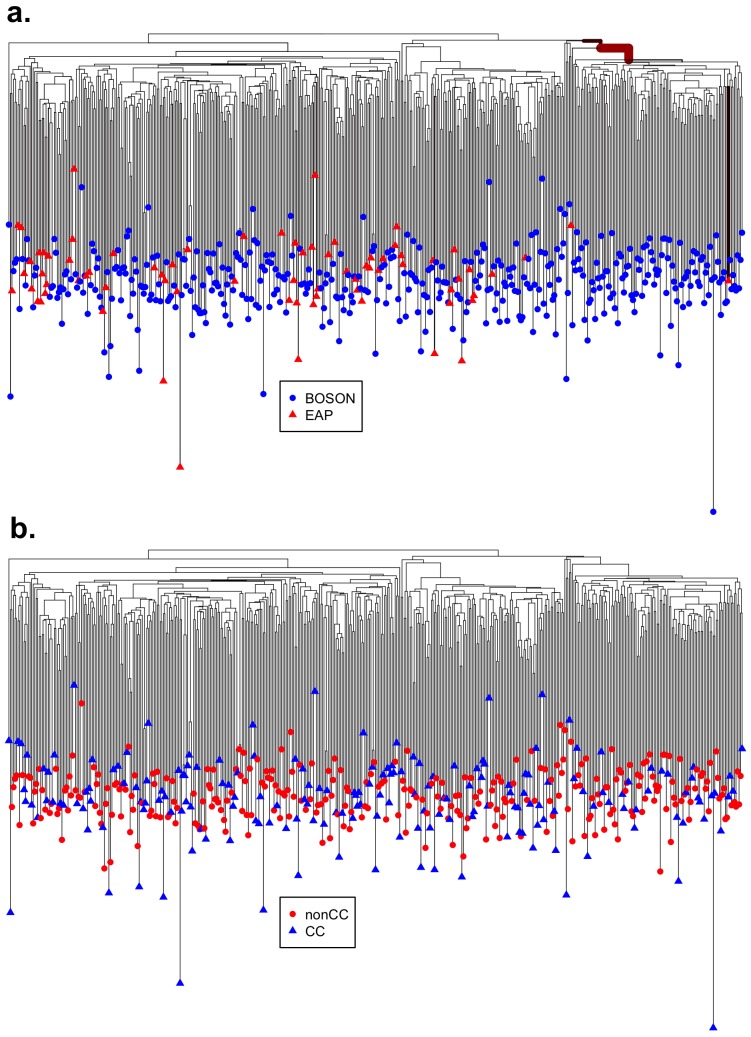
Distribution of (a) cohort from which the sequences were obtained (BOSON N = 411 or EAP N = 74) and (b) host IFNL4 SNP rs12979860 genotypes (CC or non-CC) on the virus phylogenetic tree.The thickness and redness of the branches are proportional to the posterior probability that the distribution of the trait of interest on the tips of the tree is different under that clade. (a) Bayes factor of the alternative (where there is one or more branches which have a different distribution of sequences from the BOSON and EAP cohorts) to null model (where the distribution of sequences from the BOSON and EAP cohorts is the same everywhere on the tree) is 249, indicating that the alternative model is supported. There is a branch (thick and red) on the tree, representing a clade within which there are very few EAP sequences as well as sequences from UK patients in the BOSON cohort. (b) There is no evidence that any part of the tree has a distinct distribution in terms of the host IFNL4 SNP rs12979860 genotypes, the estimated Bayes factor for alternative model (where there is one or more branches which have a different distribution of host IFNL4 genotypes) to null model (where the distribution of IFNL4 SNP rs12979860 genotypes is the same everywhere on the tree) is 1.1 which indicates that the null model that host IFNL4 SNP rs12979860 genotypes are randomly distributed on the virus tree is better supported.